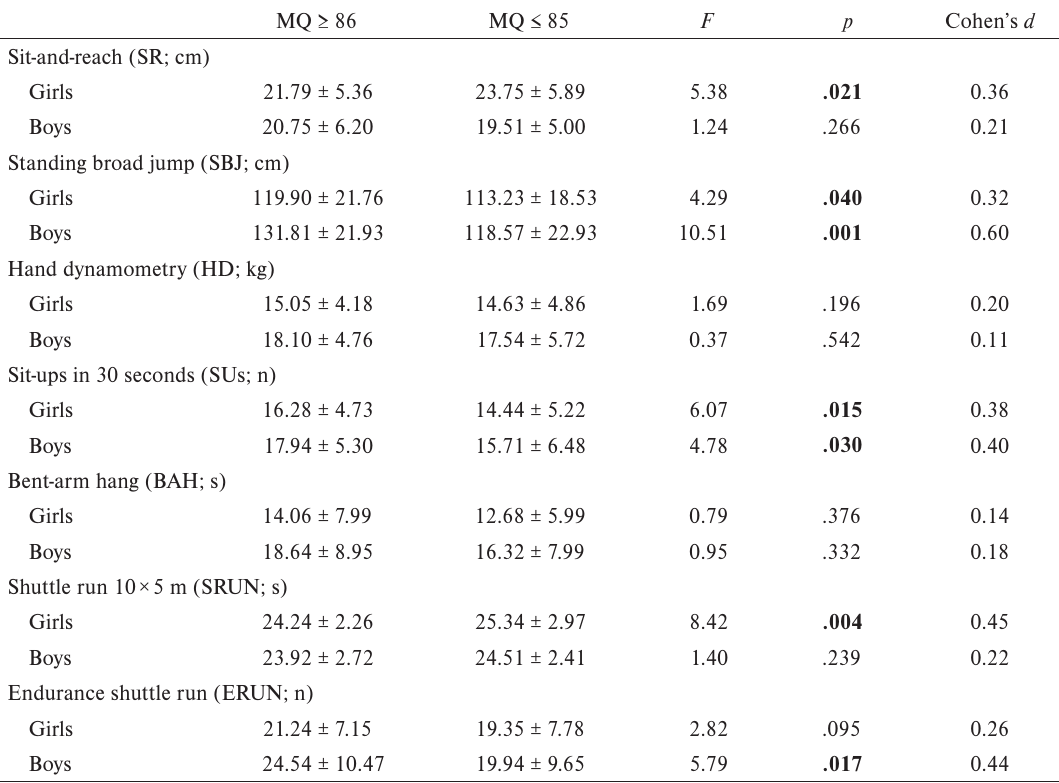
Table 3 Comparison of physical fitness indicators (presented as M ± SD) in group of girls and boys aged 7 to 10 years (N = 436) from the point of view of MQ KTK MQ ≥ 86 MQ ≤